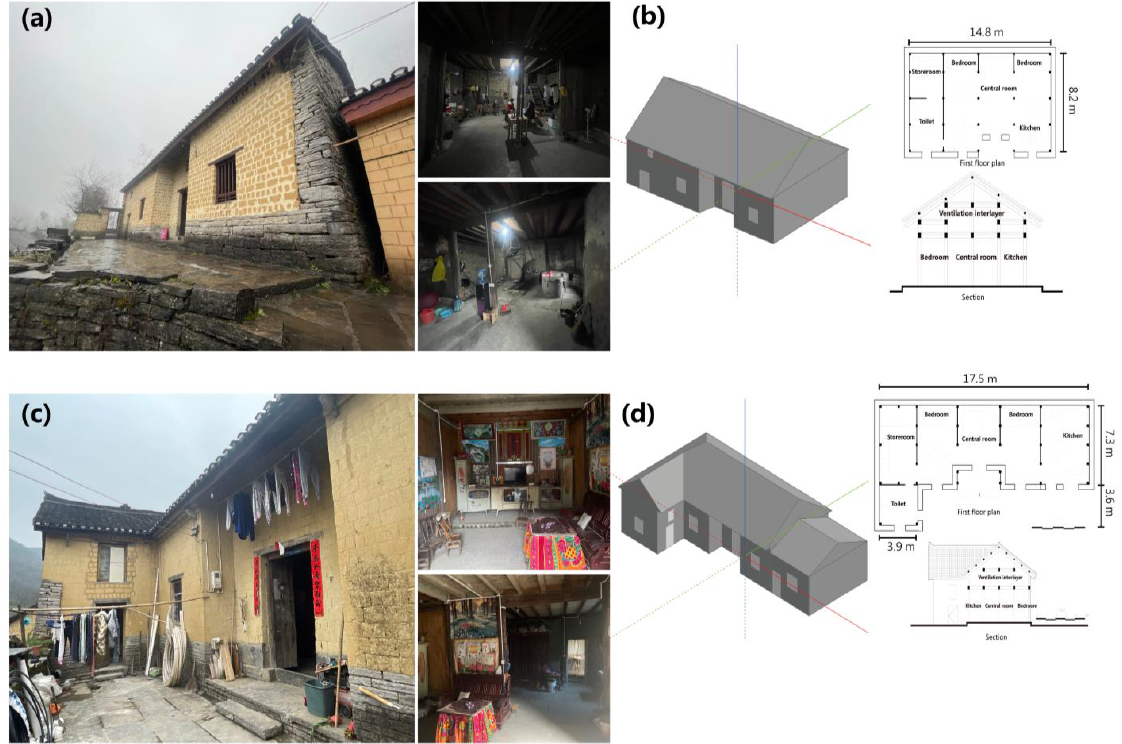
Figure 5. Concrete questions for indoor environment survey. ( a ) Photo of “I - shaped” dwelling; ( b ) Model “I -shaped ” dwelling ; ( c ) Photo of “L - shaped” dwelling; ( d ) Model “L - shaped” dwelling.